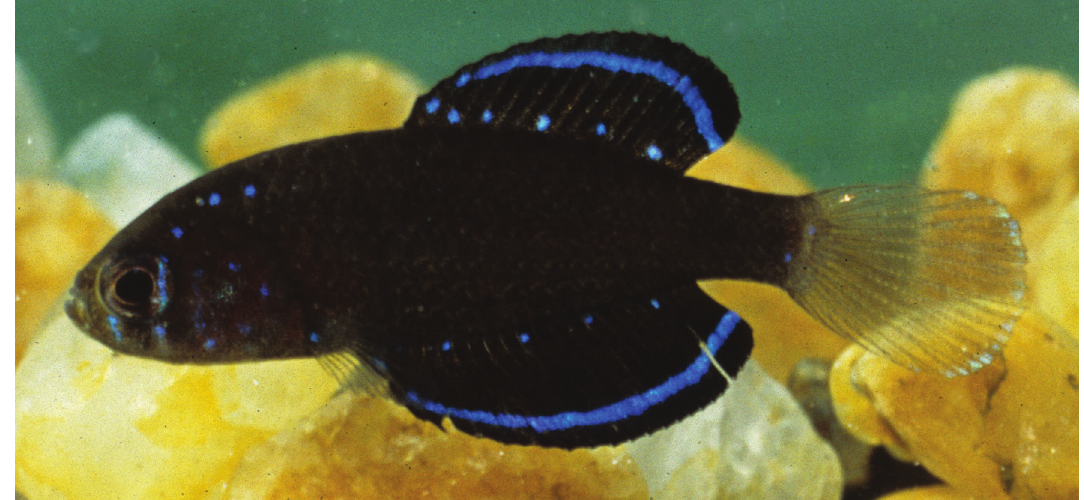
Figure 3. Specrolebias costae , UFRJ 3549, male, 18.8 mm SL; das Mortes River